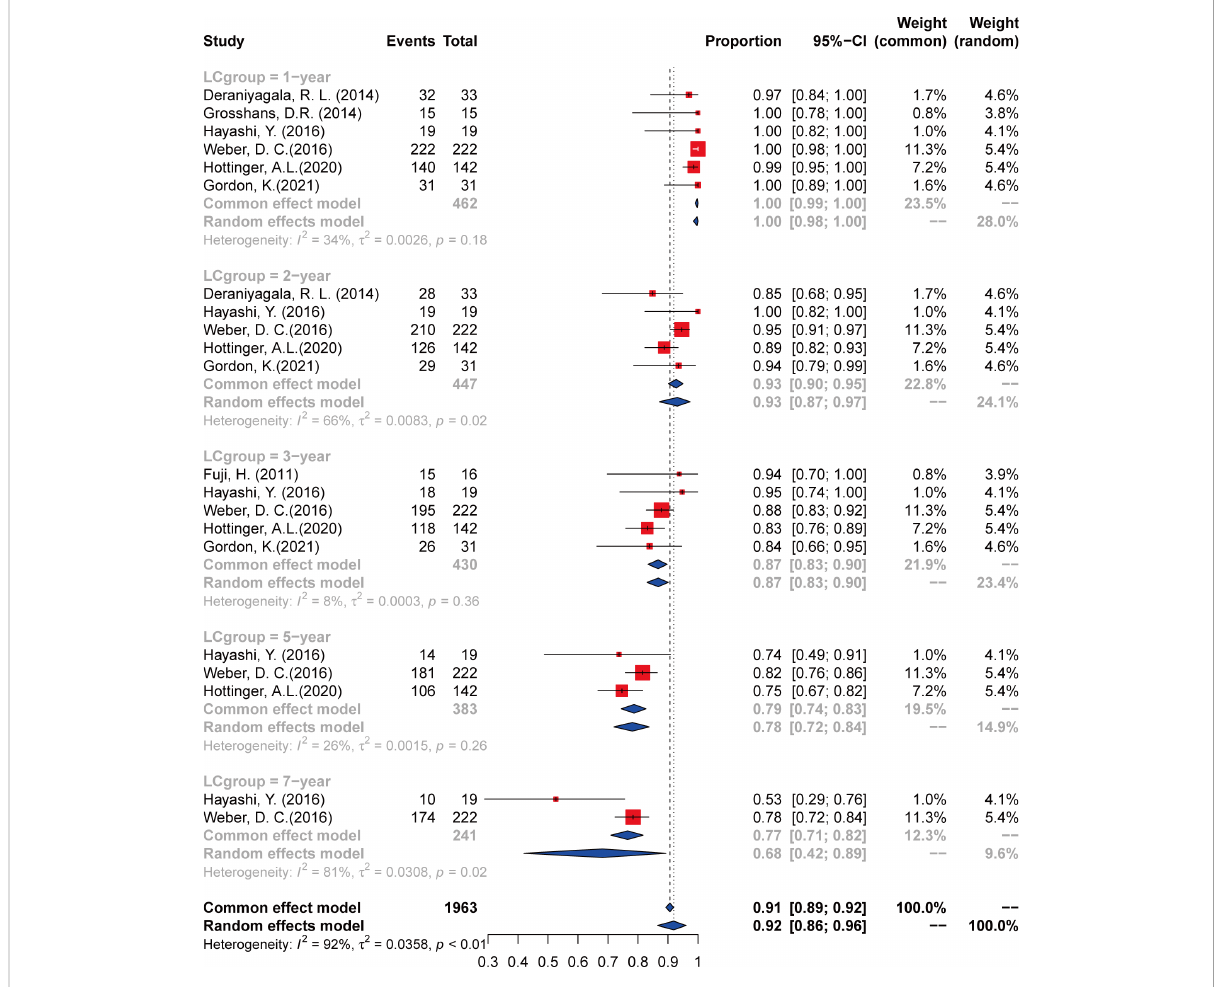
FIGURE 2 The local control of chordoma and chondrosarcoma treated with PT.